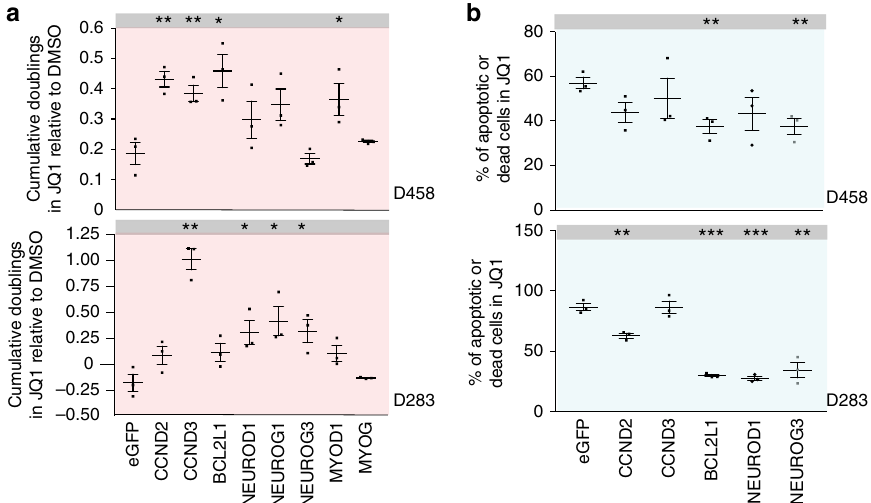
Fig. 3 Expression of cell-cycle regulators, anti-apoptosis genes and bHLH/homeobox transcription factors rescue BETi effects a Low throughput rescue assays in D458 and D283 cells expressing eGFP, CCND2, CCND3, BCL2L1, NEUROD1, NEUROG3, MYOD1, or MYOG that were treated with JQ1 1 μ M or DMSO control. Asterisks denote signi fi cant differences from eGFP controls (* p < 0.05, ** p < 0.01, *** p < 0.001) as determined by Two-tailed unpaired t -tests. Error bars depict mean ± SEM. Source data: Source Data File. b Percentage (%) of apoptotic or dead cells in D458 and D283 cells expressing eGFP, CCND2, CCND3, BCL2L1, NEUROD1, or NEUROG3 treated with JQ1 2 μ M for 72 h. Asterisks denote signi fi cant differences from eGFP controls (** p < 0.01, *** p < 0.001) as determined by two-tailed unpaired t -tests. Error bars depict mean ± SEM. Source data: Source Data File